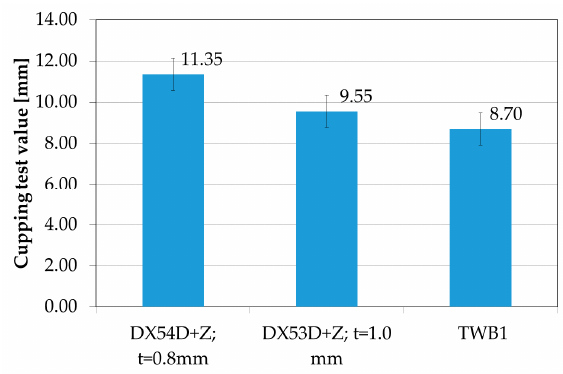
Figure 11. The Erichsen cupping test value of the base materials and TWB1.